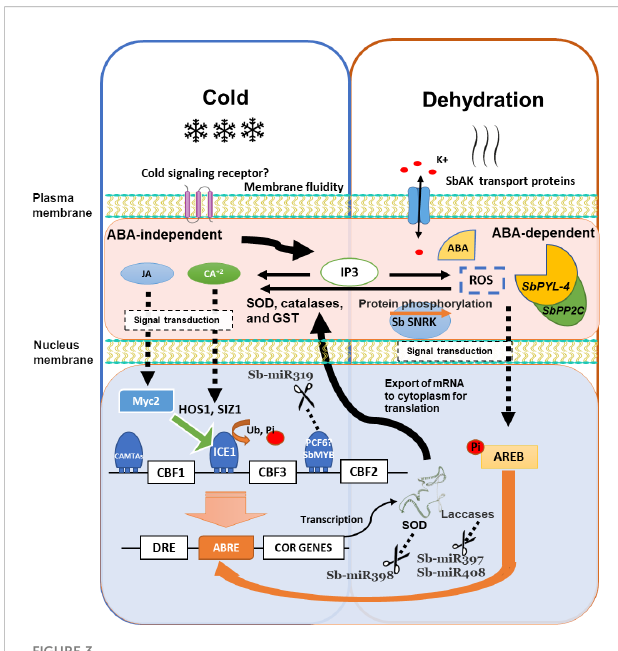
FIGURE 3 Schematic overview of the cold response and its overlapping dehydration response – mediated regulatory networks in Sorghum. Cold may be perceived by signaling receptor and the second messengers (IP3, Ca2+, and ROS), transducing signals through protein kinases or TF cascades. CBF s are activated by ICE1 and CAMTA TF. HOS1 and SIZ1 regulate ICE1 protein. Cold stress activates ICE1 , and AREB is induced by ABA. The DRE element is recognized by CBF1 and control COR genes. MiR398, miR397, and miR408 regulate some COR genes. The JA signaling pathway activates MYC2 , which can activate the expression of ICE in ICE-CBF-COR cold resistance pathway. ROS, reactive oxygen species; IP3, inositol 1,4,5-triphosphate; CPK, calcium-dependent protein kinase; MAPK Ras, mitogen-activated protein kinase; Pi, phosphoryl group; miR, microRNA; SOD, superoxide dismutase; GST, glutathione S-transferase; CBF1 , C-repeat binding factors; Ub, ubiquitin; SUMO, small ubiquitin – related modi fi er. Modi fi ed by Shi and Yang